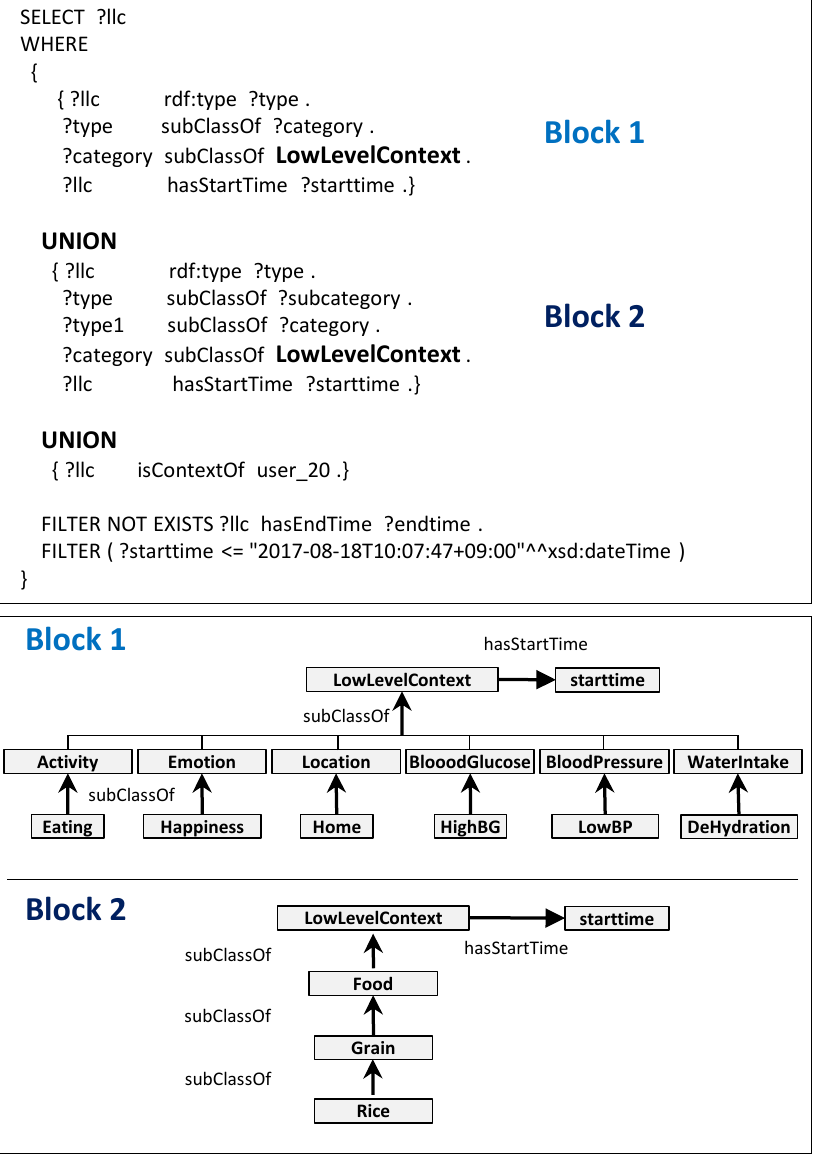
Figure 9. Evidential mappings of MMCO with SPARQL Query while retrieving Concurrent low-level Context w.r.t